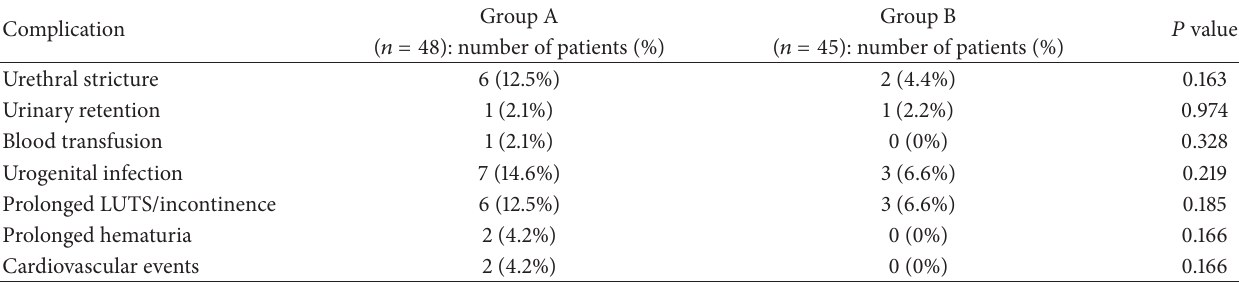
Table 6: Comparison of surgical complications between the two